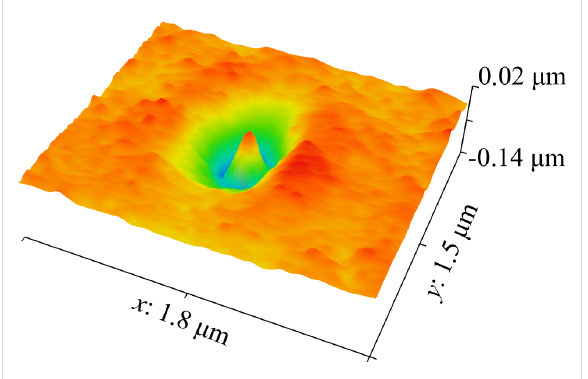
Figure 7: A representative AFM image of a nanostructure on an Ag surface after sustaining damage from N plasma cleaning. Constant EB parameters are: U = 30 kV, I = 52 pA, d = 11 nm, t = 60 s, and α =